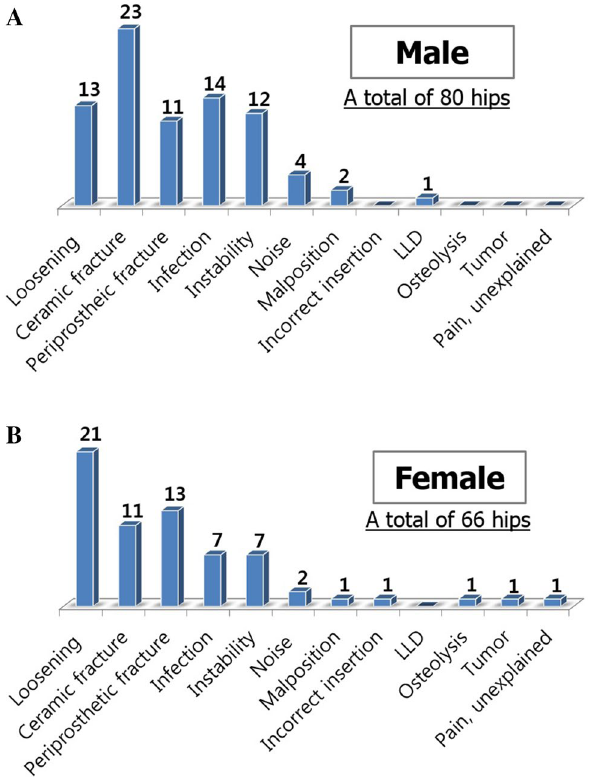
Figure 2. ( A , B ) The reasons for CoC THA revisions according to